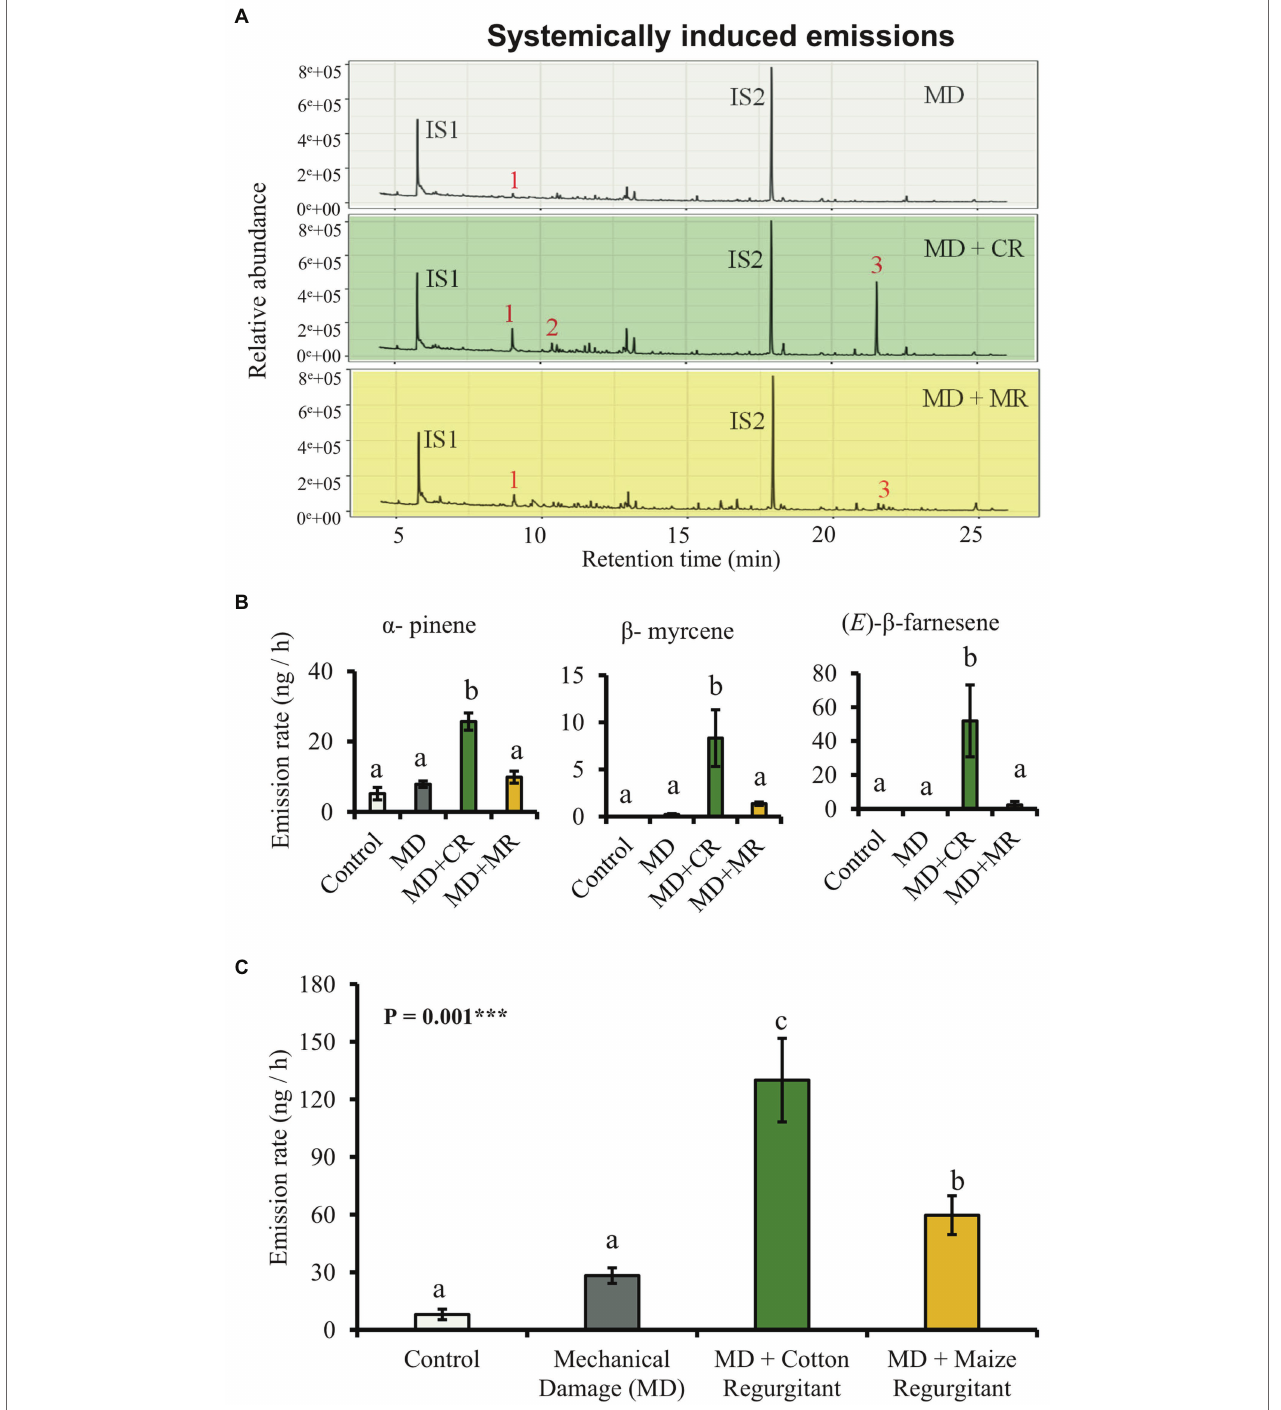
FIGURE 3 | Cotton plants systemically emit different amount of volatiles in response to elicitation by different caterpillar regurgitants. Plants were subjected to the following treatments: undamaged (Control), mechanically damaged (MD), and application of regurgitant of cotton-fed S. exigua (MD + CR), and mechanically damaged and application of regurgitant of maize-fed S. exigua (MD + MR; n = 6). (A) Typical GC-MS chromatograms of HIPV from cotton plants 48 h after elicitation. The identities of the compounds are: 1: α -pinene, 2: β -myrcene, 3: ( E )- β –farnesene, IS1 and IS2: internal standards (20 ng/ μ l), and n -octane and nonyl acetate, respectively. (B) Average (±SE) of the most representative compounds emitted by cotton plants 48 h after elicitation. (C) Average (±SE) of total amount of volatiles emitted by systemically treated cotton plants 48 h after elicitation. Different letters indicate significant differences among treatments ( p < 0.05). p values are given for treatments [GLM (family, Gaussian)] followed by pairwise comparisons of LSMeans. *** p < 0.001 and * p <